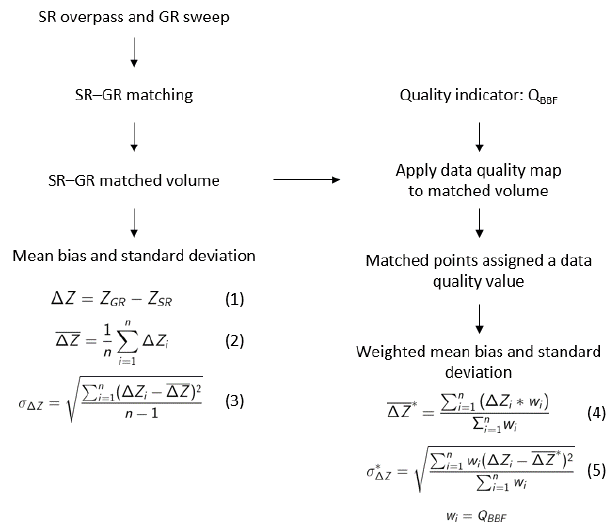
Figure 4. Flowchart describing the processing steps to calculate the mean bias and the weighted mean bias between ground radar data and satellite radar data. The results of each step are shown in Sect.